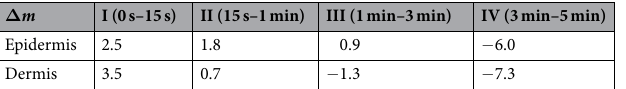
skin layer from the bottom, and top layer, (kg); Δ m is the water mass variation, calculated by ( m st − m wl ), indicat- ing the change in the total amount of water in the system, (kg). Δ T is the temperature variation of water due to heat transfer to skin, (K). To simplify this analysis, we assume that temperature variation ( Δ T ) of condensed water and evaporated water is the same, based on Eq. 3, and that the weight change of a layer is only due to condensation/evaporation effects, with no liquid water transfer between the layers. Then the water mass variation Δ m ( m st − m wl ) deter-